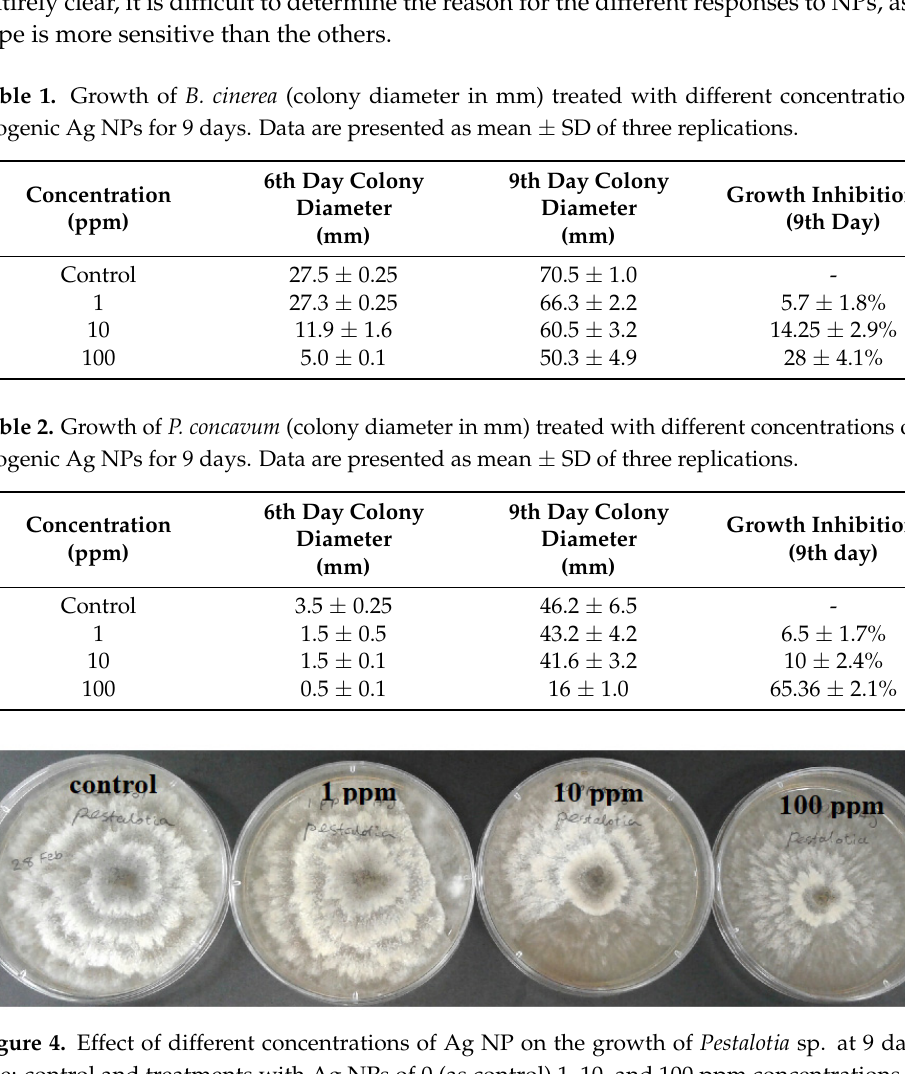
Figure 4. Effect of different concentrations of Ag NP on the growth of Pestalotia sp at 9 days of age: control and treatments with Ag NPs of 0 (as control) 1, 10, and 100 ppm concentrations, agar dilution method.